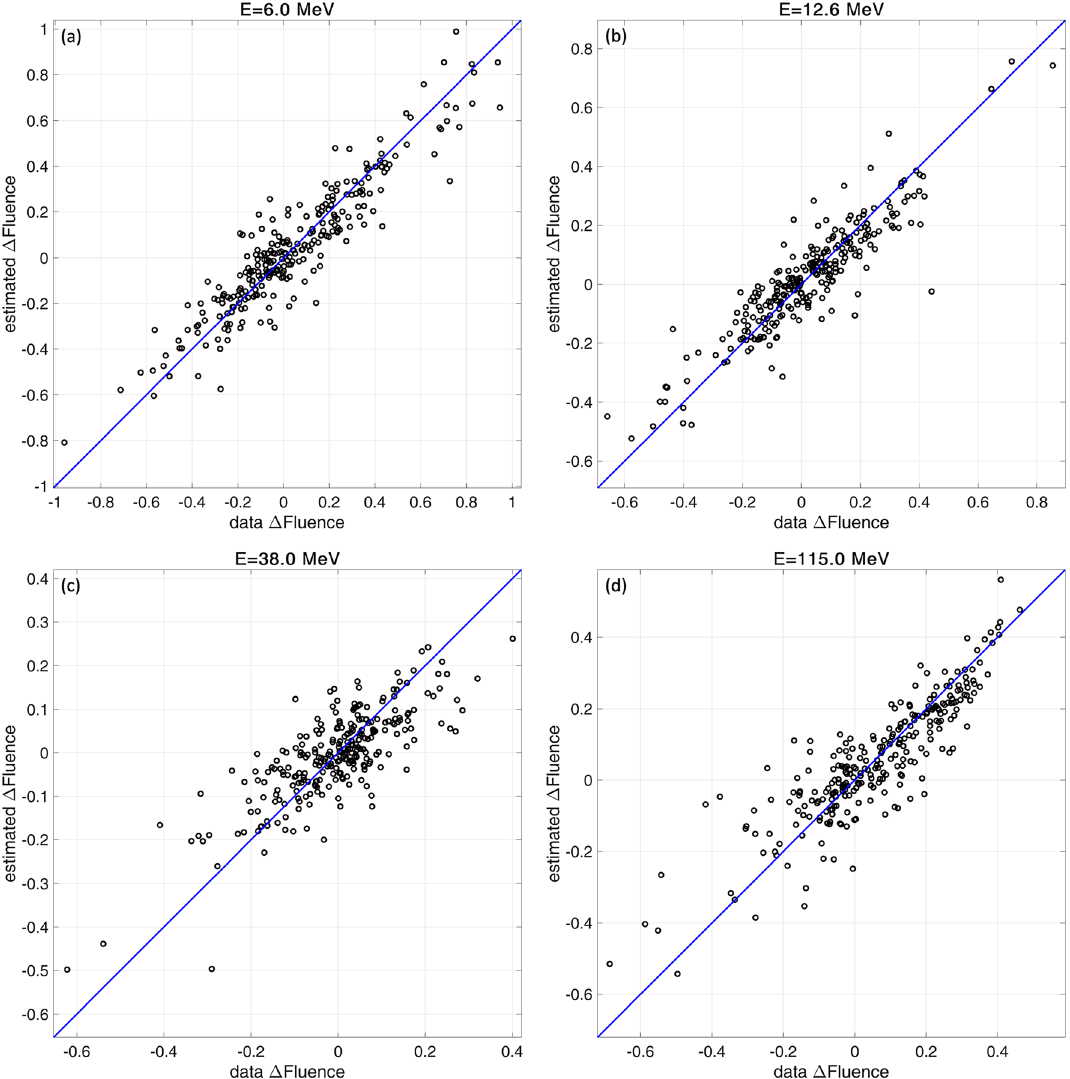
Fig. 8. Cross-plots of Fluence residuals derived from data and estimated from the hypersurfaces using the Peak residuals, y = x equality lines are in blue. (a) 6 MeV, (b) 12.6 MeV, (c) 38 MeV and (d) 115